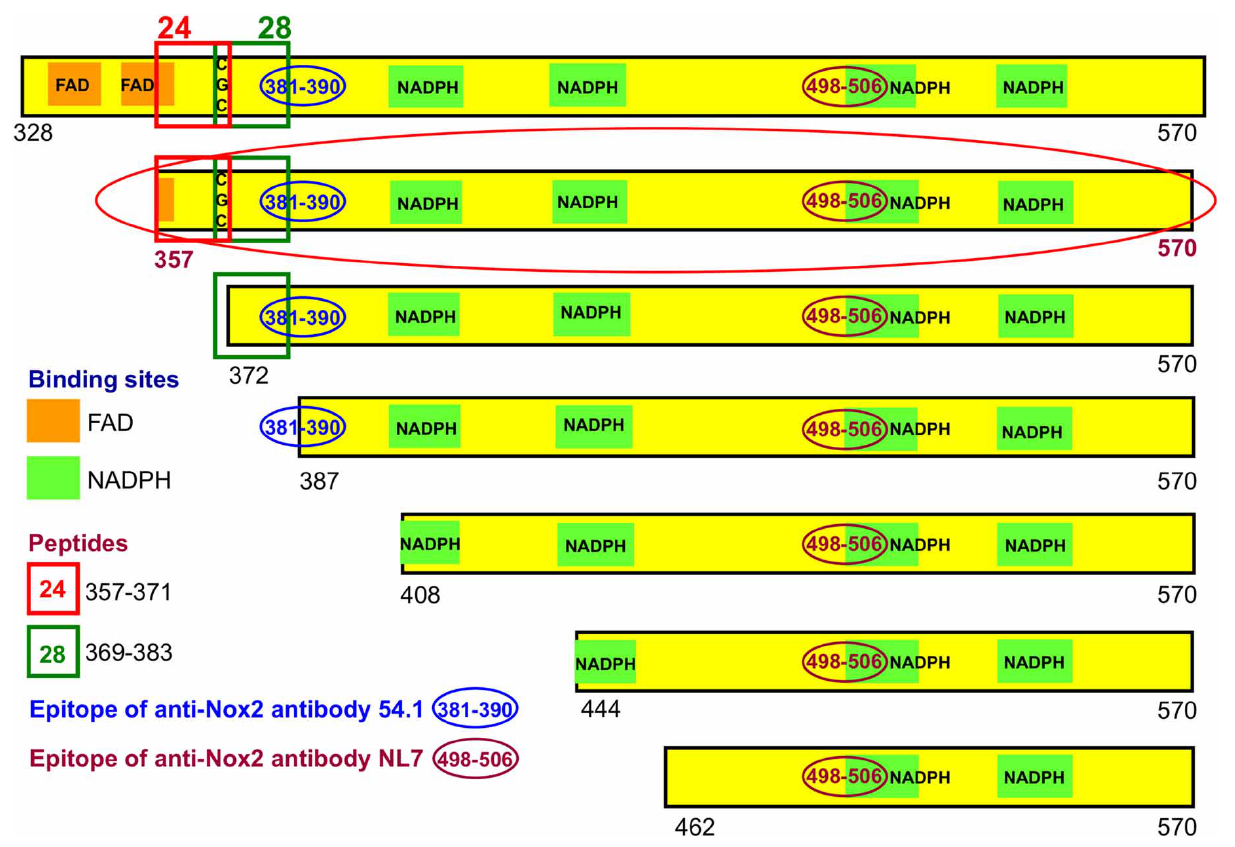
part of the fusion proteins. It also illustrates the location of peptides 24 (357–371) and 28 (369–383); the position of the FAD- and NADPH-binding sites, and the epitopes of the two monoclonal anti-Nox2 antibodies used in the present work. The truncation most used (357–570) is marked by a red-colored